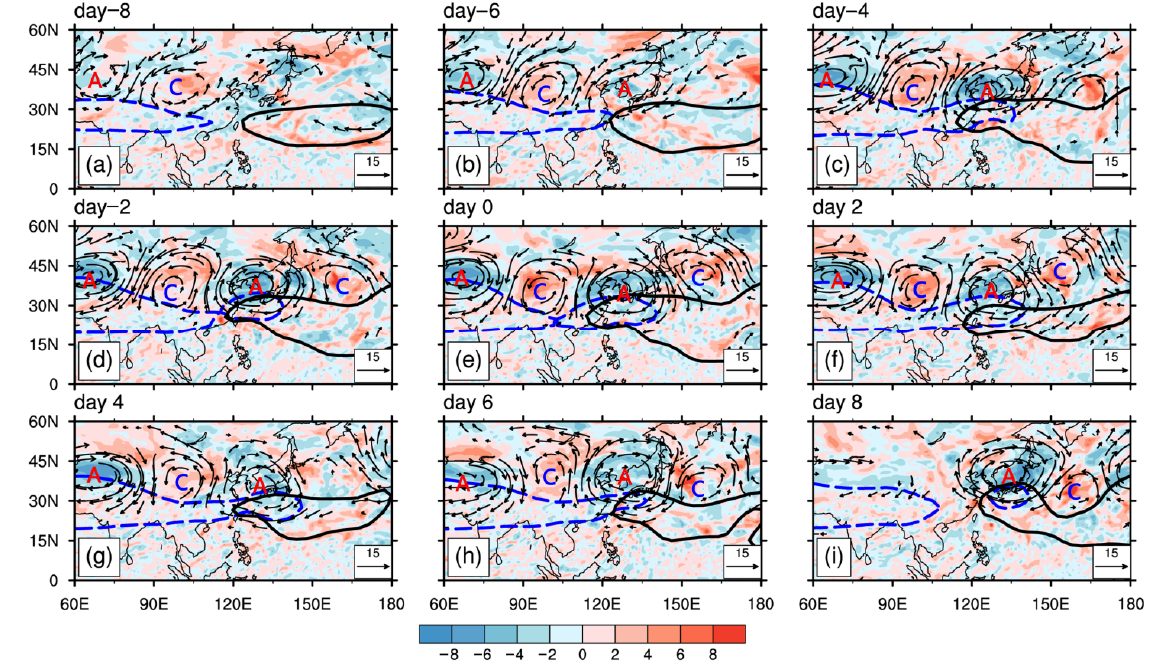
Figure 10. Composite average horizontal wind anomalies at 200 hPa (vector; units: m s −1 ) and the relative vorticity (shadings; units: s −1 ) during the SRP+ events from day −8 to day 8 ( a – i ). The thick black contours (588 dagpm-contour) and the blue dashed contours (1250 dagpm-contour) denote the activities of WPSH at 500 hPa and SAH at 200 hPa, respectively. The letters ‘C’ and ‘A’ represent an anomalous cyclone and anticyclone,